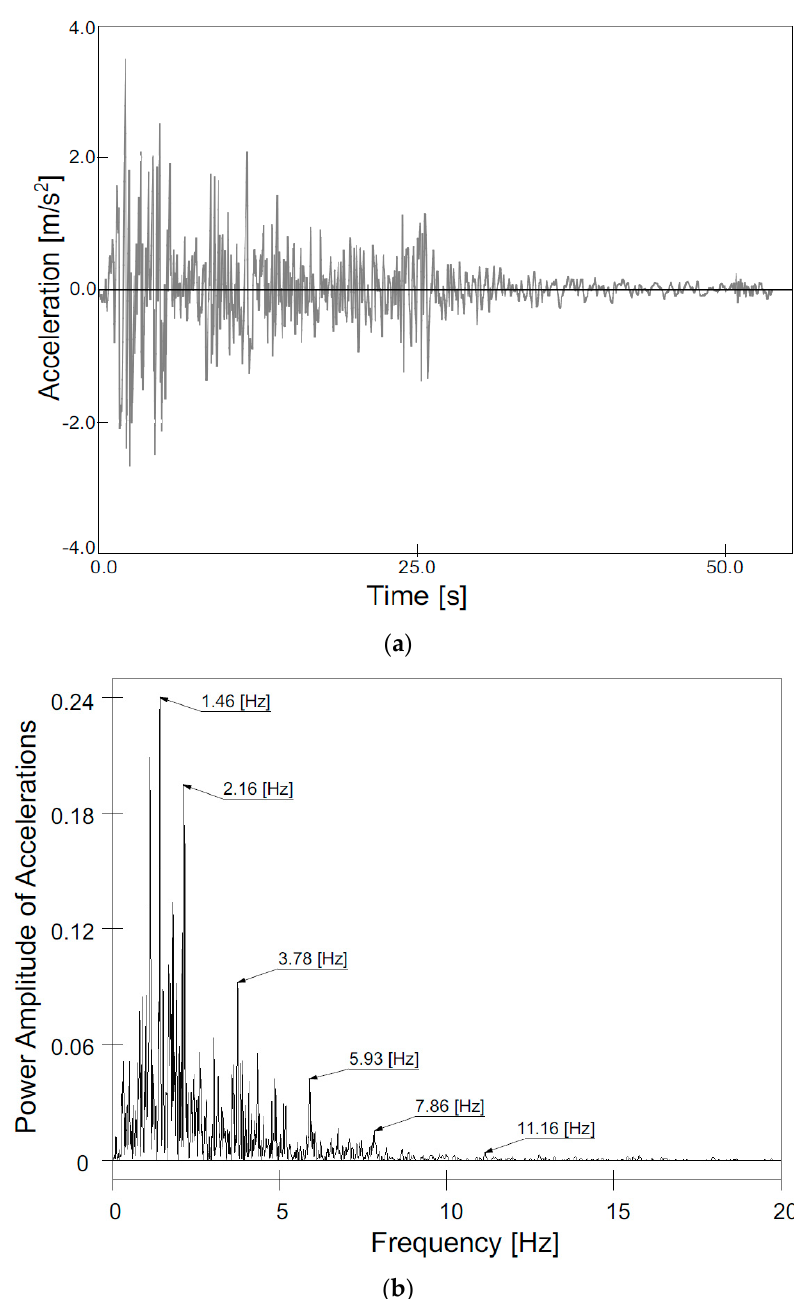
Figure 4. El Centro earthquake from 18 May 1940: ( a ) Record of ground motion of (NS) component, ( b ) frequency of vibration.